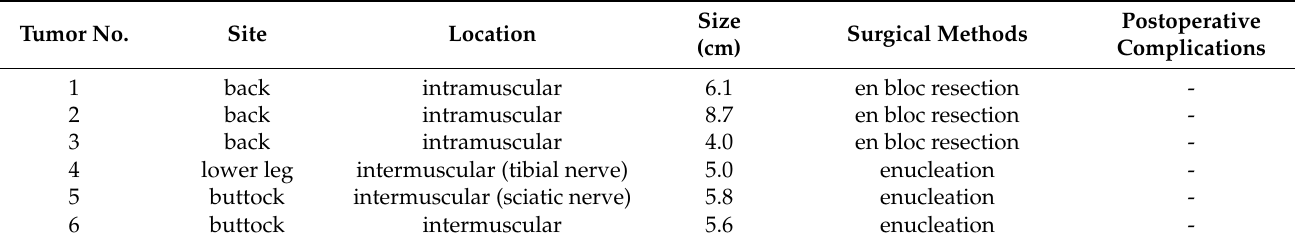
Table 2. The detailed information of 24 nodular plexiform